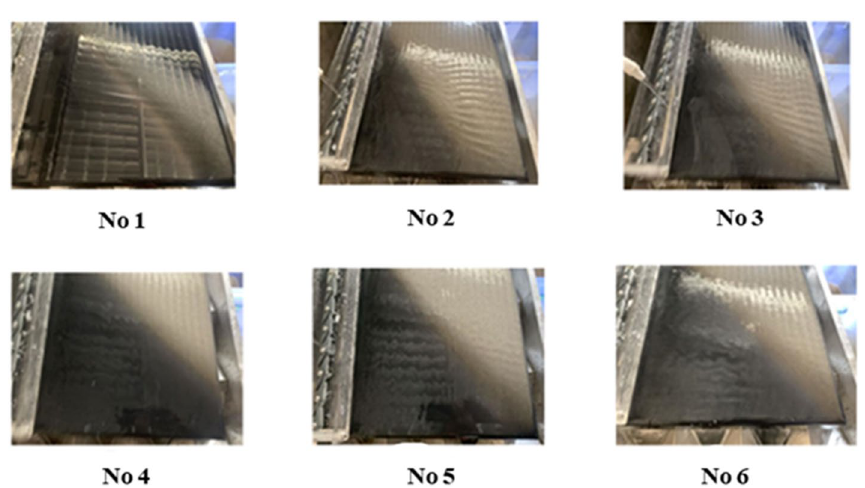
Figure 15. Six representative ore belt images to be optimized.